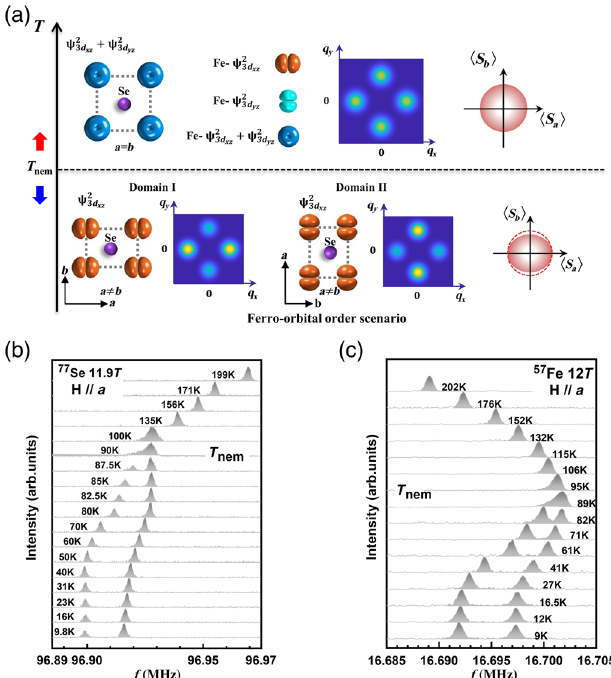
FIG. 1. NMR evidence for the Ising nematic transition in FeSe. (a) Illustrative diagram of the Ising nematic transition in FeSe. Above T , the system is in a paramagnetic state with an isotropic nem dynamic spin correlation [ χ 00 ð q Þj ]. Moreover, the ¼ χ 00 ð q Þj ð π ; 0 Þ ð 0 ; π Þ 3 d 3 d xz and yz orbitals are also degenerate. In such a state, the local- spin susceptibility is also isotropic within the ab plane (indicated as a pink circle in the h S a i vs h S b i plot, in which h S a i and h S b i represent the local-spin polarization within the ab plane). With the temperature lowering, a ferro-orbital ordering between the 3 d xz and 3 d yz orbitals accompanied by an orthorhombic lattice distortion ( a ≠ b ) takes place at T (indicatedas the dashedblack line). Two nem kinds of structural domains with different orbital polarizations appear equally, which always leads to a splitting in the NMR spectrumwith H k a [Figs.1(b)and1(c)].BecauseofSOC,thelocal- spin susceptibility is expected to gain a slight anisotropy in each domain[36](indicatedasapinkellipseinthe h S a i vs h S b i plot).The dynamicspincorrelationiscoupledwiththe orbitalorderandshows ananisotropic nature.Here,whateverthe drivingforce is for suchan Ising nematic transition, the orbital order and anisotropic dynamic spin correlation are always twisted [37,38]. (b,c) Normalized NMR spectra for 57 Fe and 77 Se nuclei with H k a . Below T , a clear nem splitting of the line shape due to the formation of the nematic domains as discussed above is shown in the spectra for both the 57 Fe and 77 Se nuclei. It should be noted that the two splitting NMR lines for the 77 Se nuclei show different intensities, which are caused by a partial detwinning due to unintentional strain from the tight NMR coils. We determine that such unintentional strain did not change any NMR results in the study and that the strain could be easily removed using loose NMR